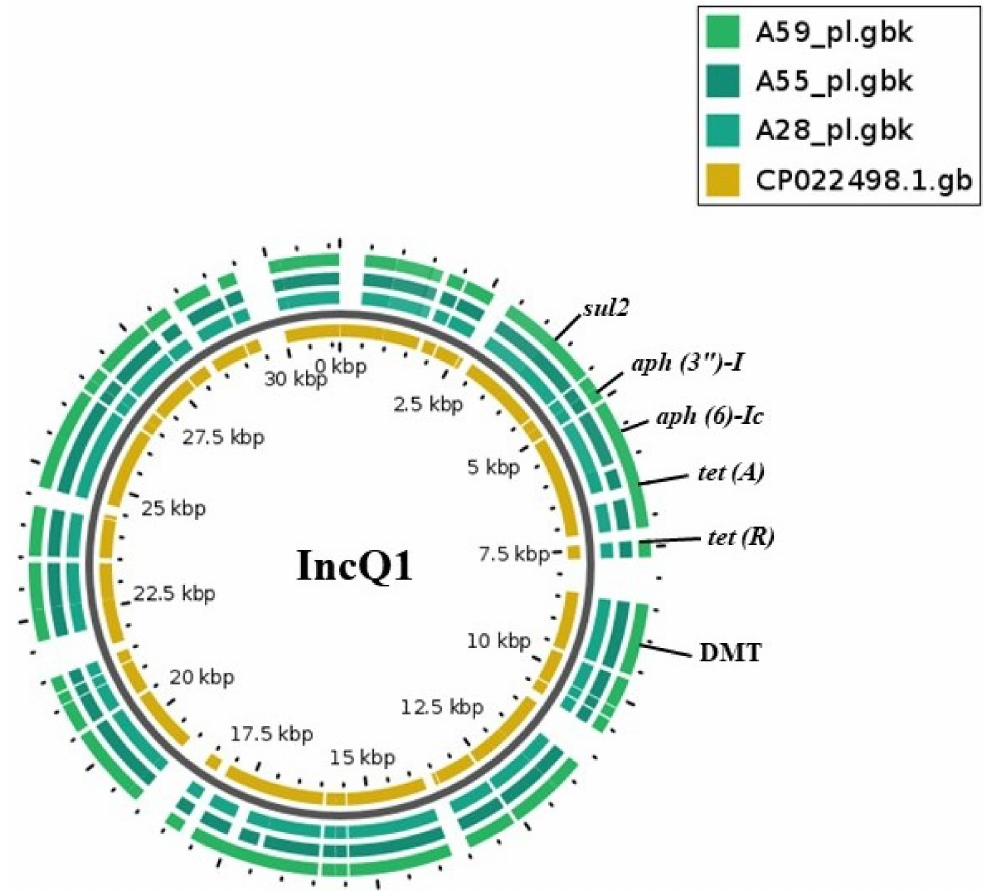
Figure 2. BLAST atlas created using GView of IncQ1 plasmids from S . Muenster carrying multidrug resistance genes with the reference plasmid CP022498.1. The innermost ring represents the genes of the reference plasmid, while the three outermost rings are the query plasmids from this study. Genomic locations of resistance genes are labeled. The permease of the drug/metabolite transporter (DMT) superfamily is also